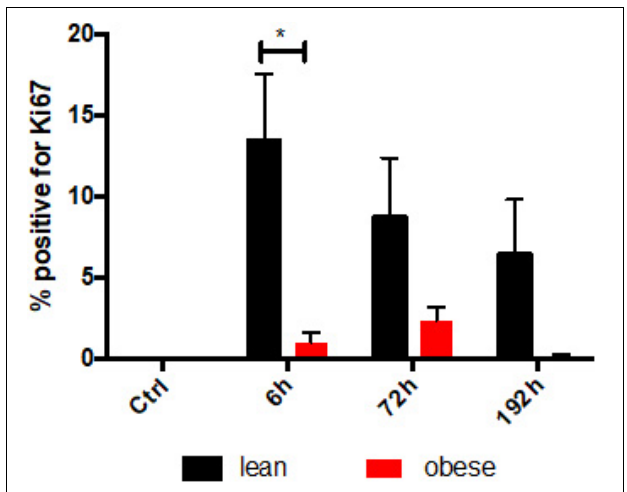
FIGURE 9 | Decreased proliferationin the tissue after trauma induction based on IHC staining of KI67 in obese animals. Ki67 stainings were evaluated for the percentage of proliferating cells in the trauma muscle in lean and obese control mice as well as 6, 72, and 192 h post trauma. The data is presented as mean ± SEM ( n = 4). Statistical significance was determined using two-way ANOVA followed by an uncorrected Fisher’s LSD test ( α = 0.05). * p < 0.05. Indicators of significance directly above the bars of the diagram indicate a statistical difference to the control, while starts above the connector line show differences between the two diets at that specific time point.